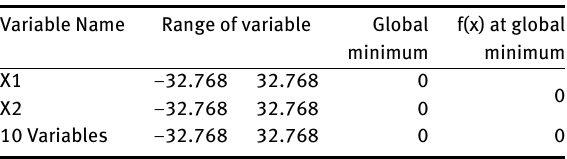
Fig. 2: A close-up of Ackley’s path function with domain of variables between − 2 and 2.